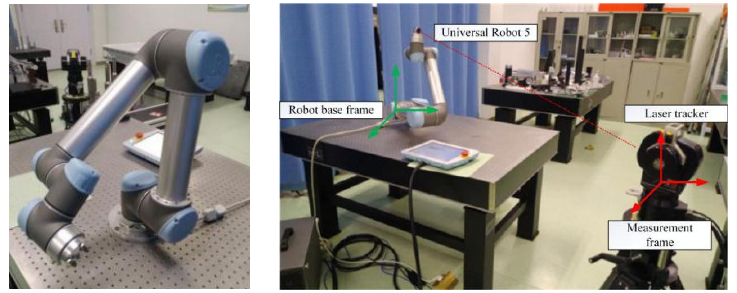
Figure 10. The experimental setup.